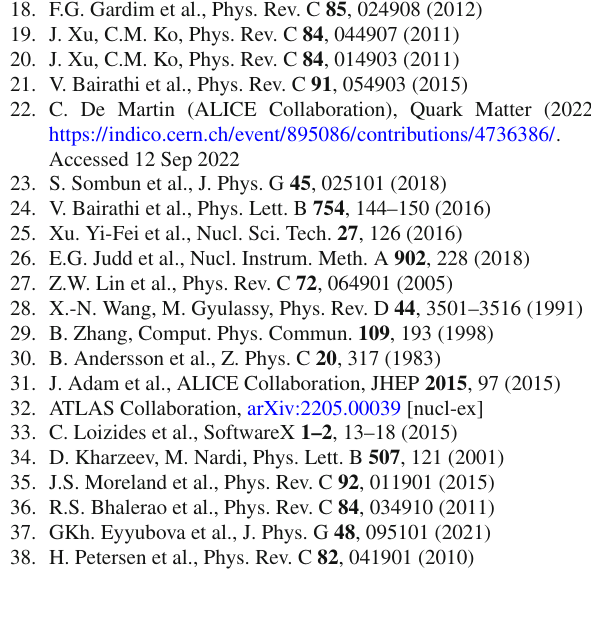
Fig. 6 Plots for minimum-bias Au+Au collisions at GeV. (Left) d N ch / d g η / N part vs. N part ; (center) d N ch / d η / N coll vs. N part ; (right)Geometricscaling N coll / ( N part ) 4 / 3 vs. N part [12].Centralityaver-